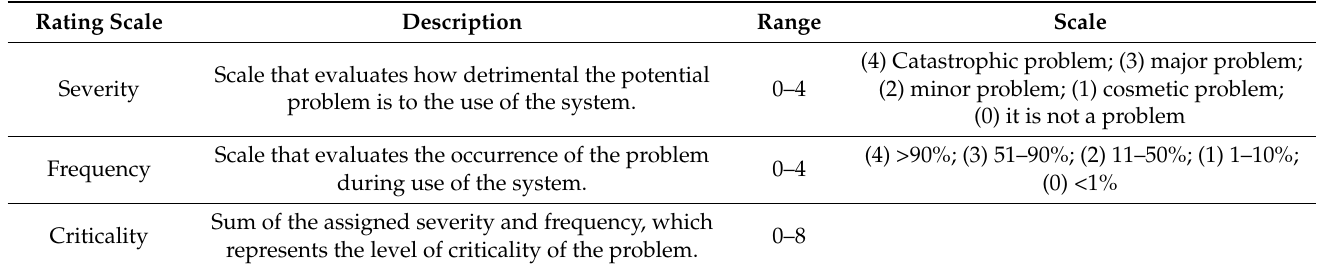
Table A3. Rating Scales of Problems Detected.